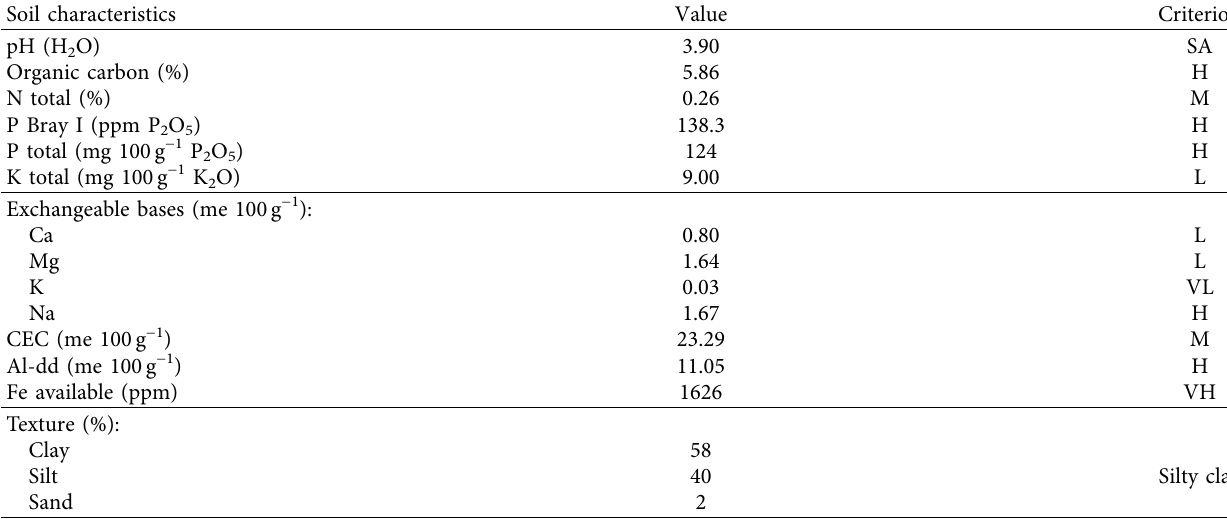
Table 6: Characteristics of soil that originated from KP Blandean, Barito Kuala District, South Kalimantan Province. Soil characteristics